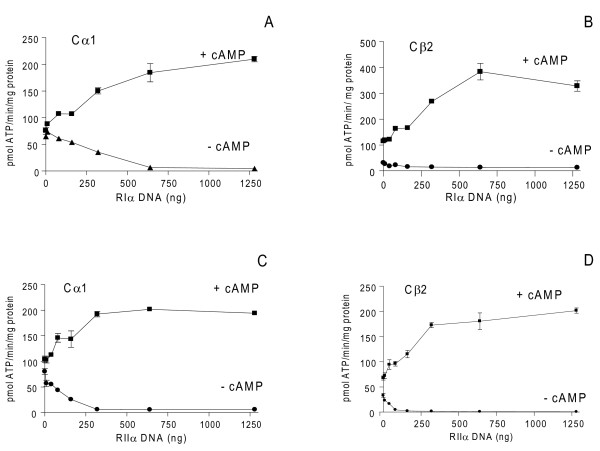
Expressed RIα and RIIα inhibit expressed Cα1 and Cβ2 catalytic activity in a dose-dependent manner. 293T cells were co-transfected with increasing amounts (0-1280 ng) of either pDeRIα (A and B) or pExRIIα (C and D) with a fixed amount of pDeCα1 (300 ng, A and C) or pDeCβ2 (1400 ng, B and D). Cells were harvested after 24 hours, cell extracts adjusted to 1 mg total protein/mL and assayed for PKA-specific phosphotransferase activity in the presence (+ cAMP) and absence (- cAMP) of 7.14 μM cAMP. Data points represent pmol ATP transferred/min/mg protein) +/- SD (n = 2-6).